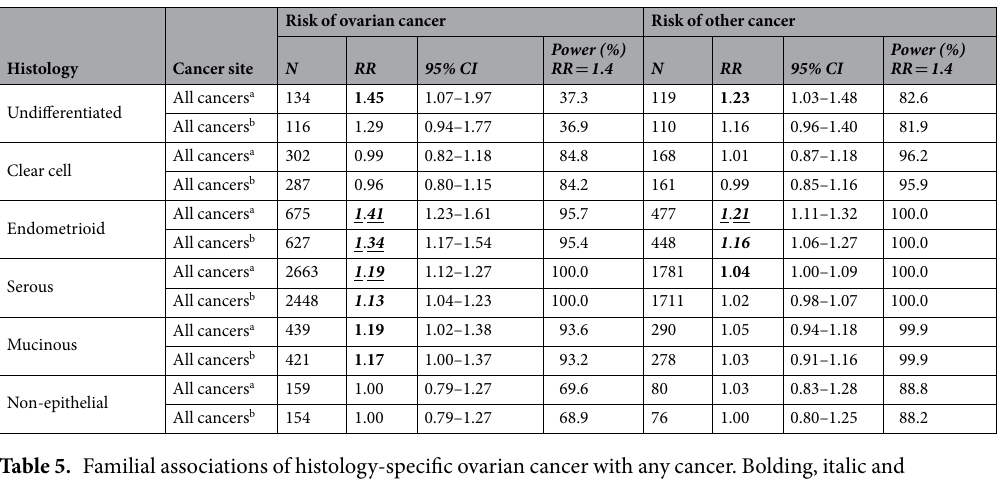
Table 5. Familial associations of histology-specific ovarian cancer with any cancer. Bolding, italic and underlining indicate that the 95% CI, 99% CI and 99.9% CI did not overlap with 1.00 respectively. a all cancers include ovarian cancers and all other cancers. b all cancers include all other cancers except ovarian